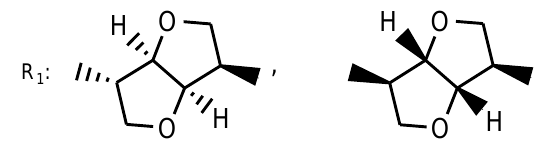
Figure 21. Chemical structure of poly(ester amide)s constituted by dianhydrohexitols,  -amino acids and dicarboxylic